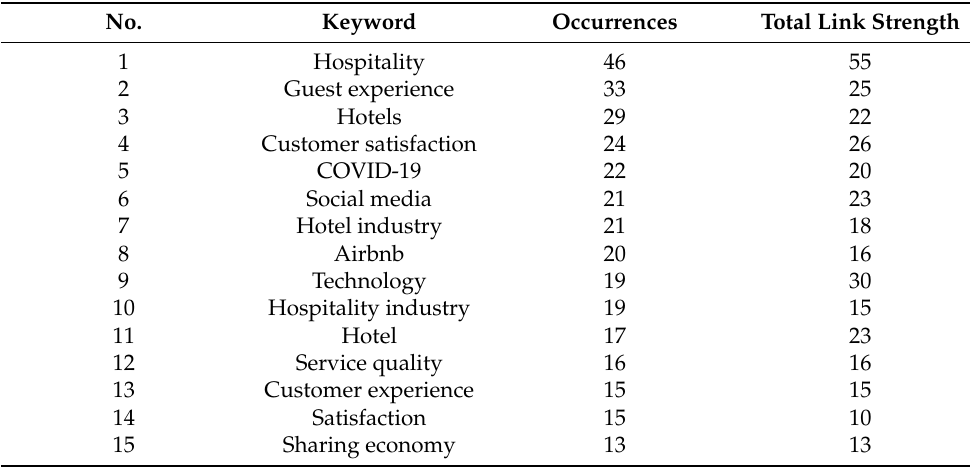
Table 8. Top keywords in the co-authorship of organizations Table 8. Top organizations in the co-authorship of organizations analysis.